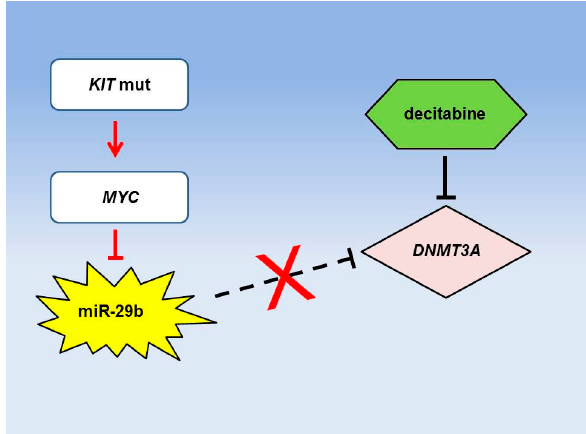
Figure 2. Example of a miRNA network influencing therapeutic sensitivity in AML low-intensity treatment. Gain of function mutations of KIT occur in AML and have been shown to decrease miR-29b expression levels via upregulation of the MYC oncogene. As a result, downregulation of the miR-29b target DNMT3A is prevented. This is of relevance for decitabine treatment, which has been shown to inhibit DNMT3A activity and which has proven to be more efficient, when DNMT3A levels are low [79,82,84].